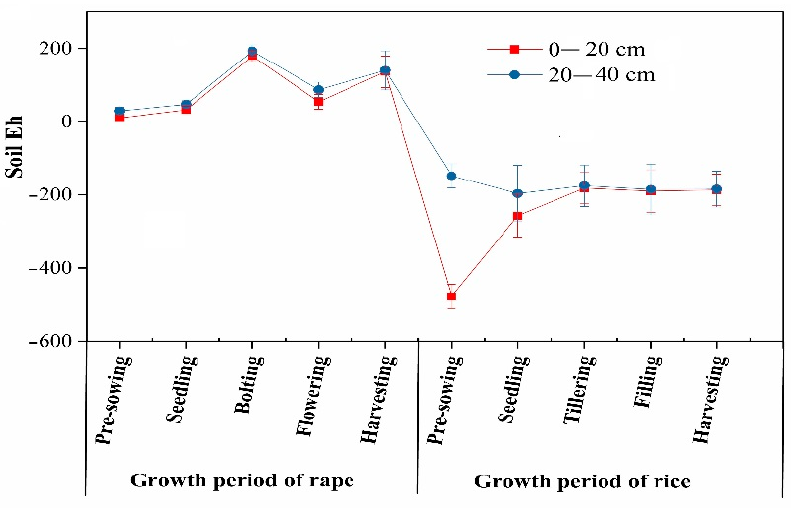
Figure 2. Variation of soil Eh during rice–rape rotation.